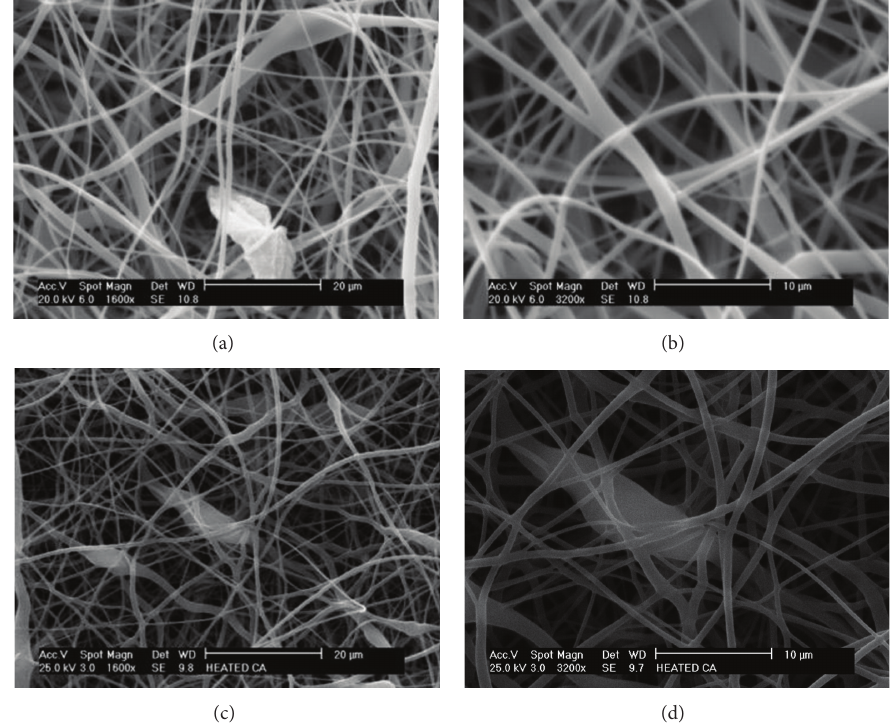
Figure 8: Selected SEM images of electrospun fibres ((a), (b)) cellulose acetate (25% w/v) web; ((c), (d)) heat-treated CA web.